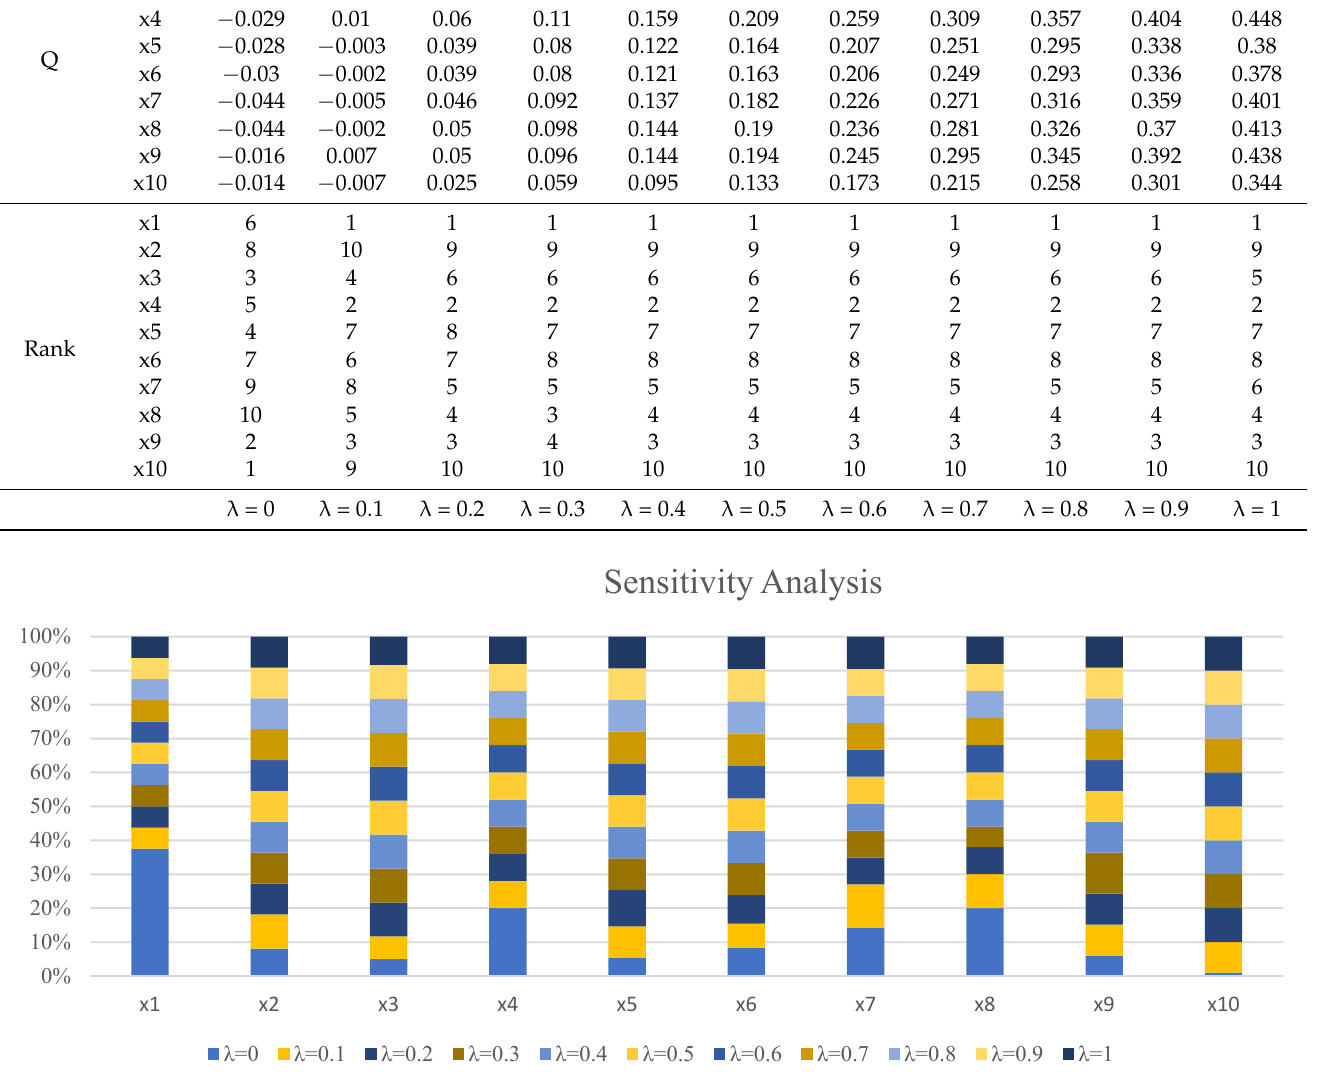
Figure 3. Sensitivity analysis of SF ‐ WASPAS.